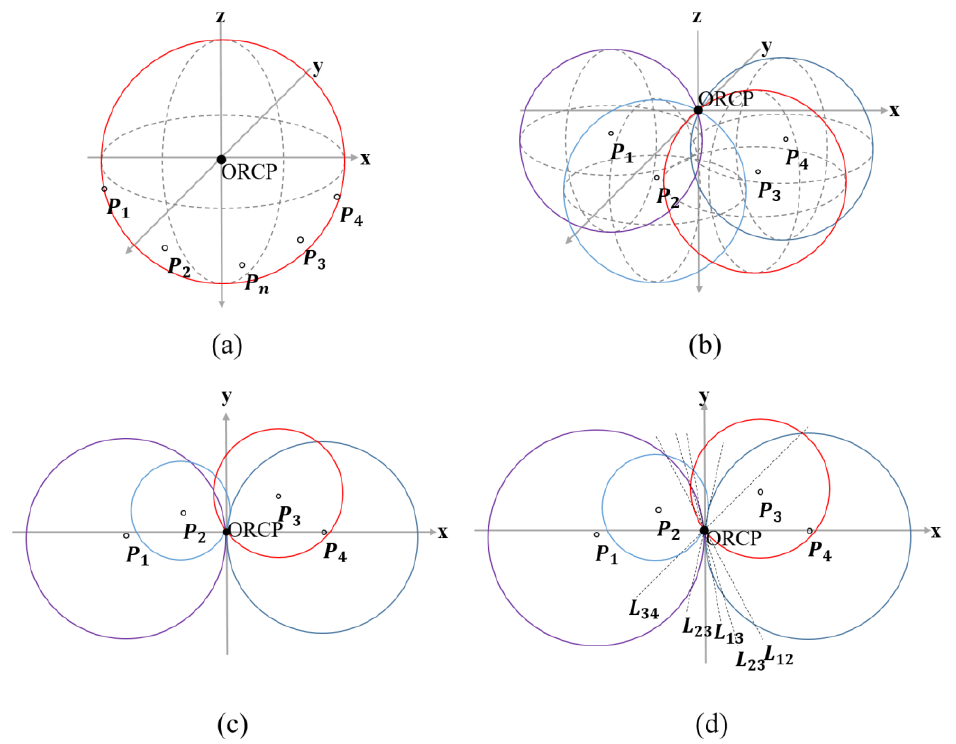
Figure 7. ( a ) The spherical orbital formed by PCP. ( b ) Candidate positions of the centre point of a spherical orbit located at a certain distance from each PCP. ( c ) Candidate positions obtained from the z-axis position of ORCP. ( d ) Lines passing through intersections of circles.